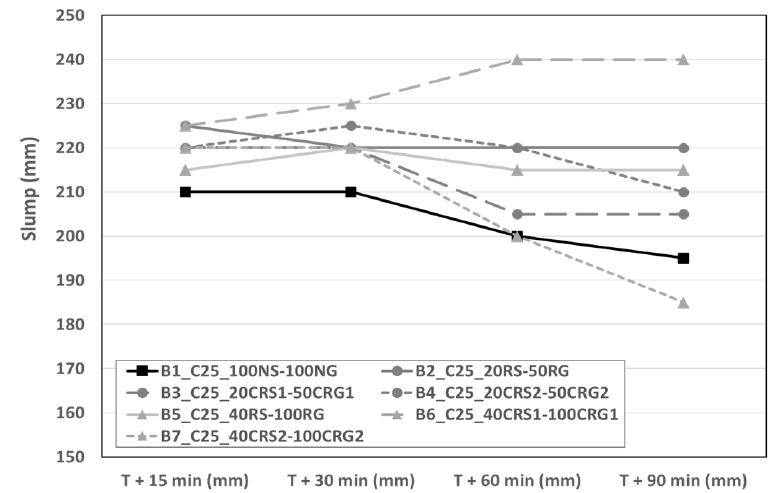
Figure 6. Measured slumps for the C25 concretes.